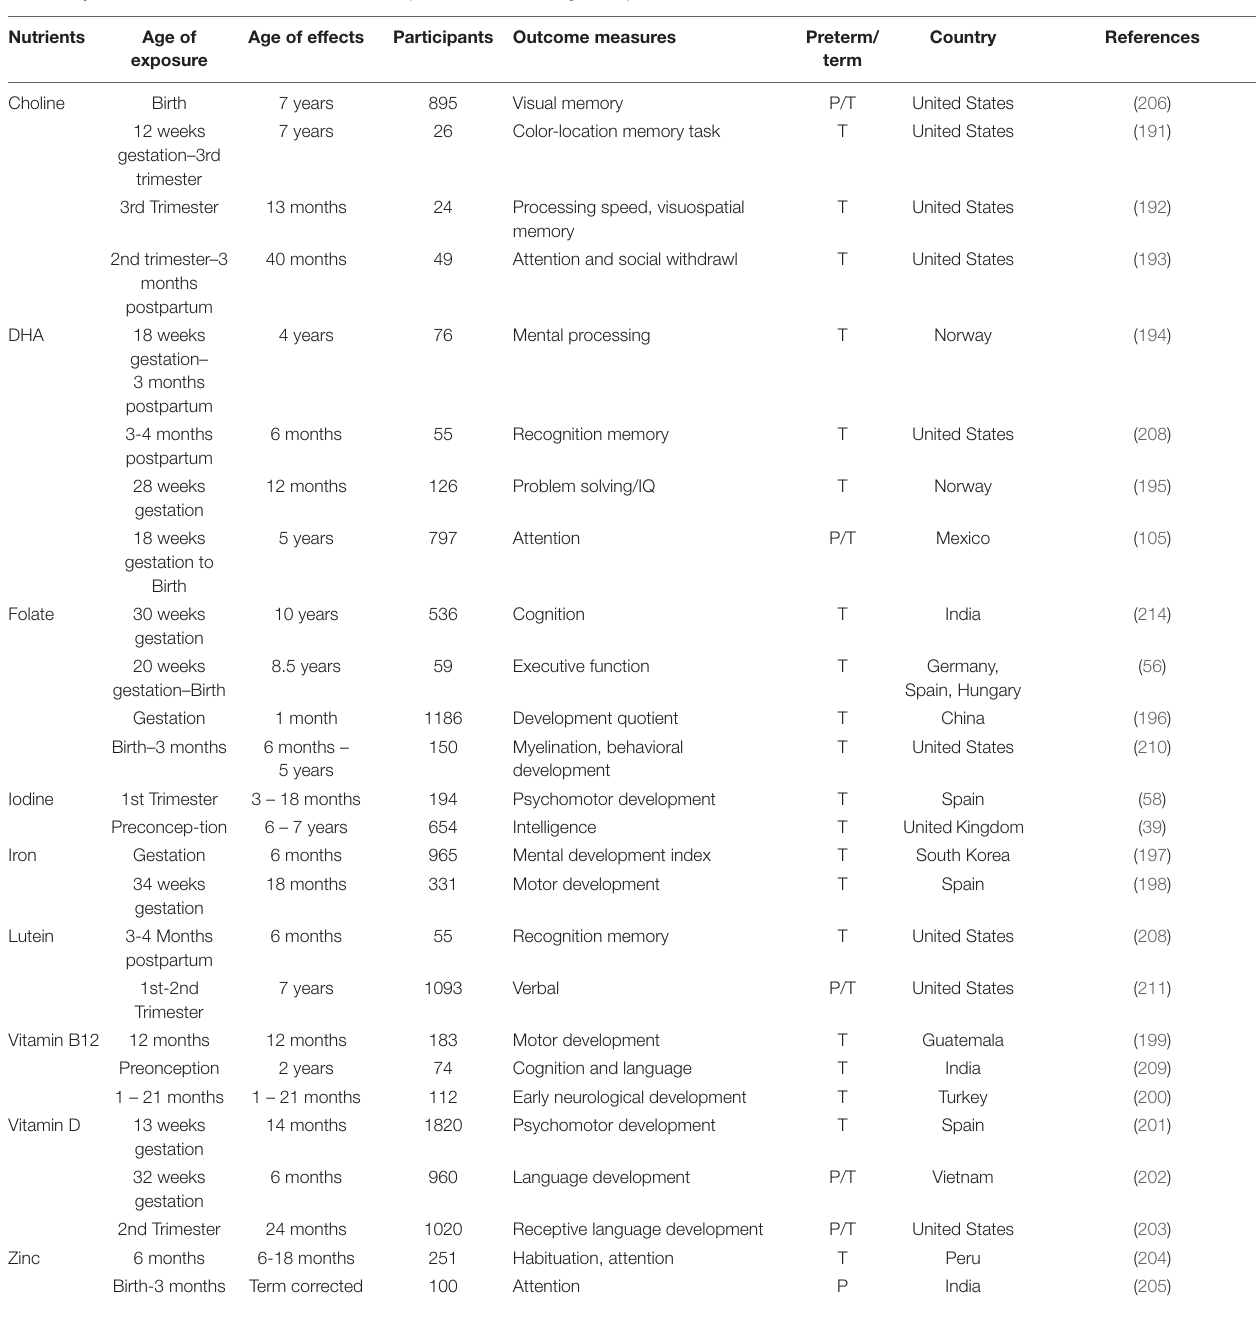
TABLE 1 | Selected nutrients studied for neurodevelopmental effects during infancy.